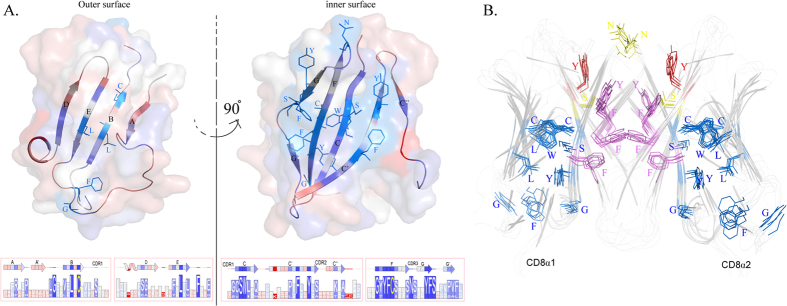
The distribution of conserved CD8α residues that are critical to guarantee its function.(A) cCD8α monomer was used as a model to show the distribution of conserved residues in CD8α. The outer surface contained A,B,E and D strands, and the inner surface contained the other strands of CD8α, which were coloured differently according to the conservation of the residues in them. The details of the residues in each position are shown in boxes with different sizes under the 3D surface illustration. (B) The classification of CD8α conserved residues based on their functions. All the conserved residues in the six CD8αα structures are shown in stick. The conserved residues which are critical to dimerization are coloured purple, and the residues taking part in the binding of MHC I according to elucidated human and mouse MHC I-CD8αα structures are coloured yellow. Only one conserved residue that plays a vital role in both dimerization and MHC I interaction is coloured red. The rest nine conserved CD8α residues not involved in these two aspects are coloured blue, and seven of them are common in other IgV molecules. The grouping indicates that only CD8α-specific conserved residues are critical to guarantee its continued function during evolution.